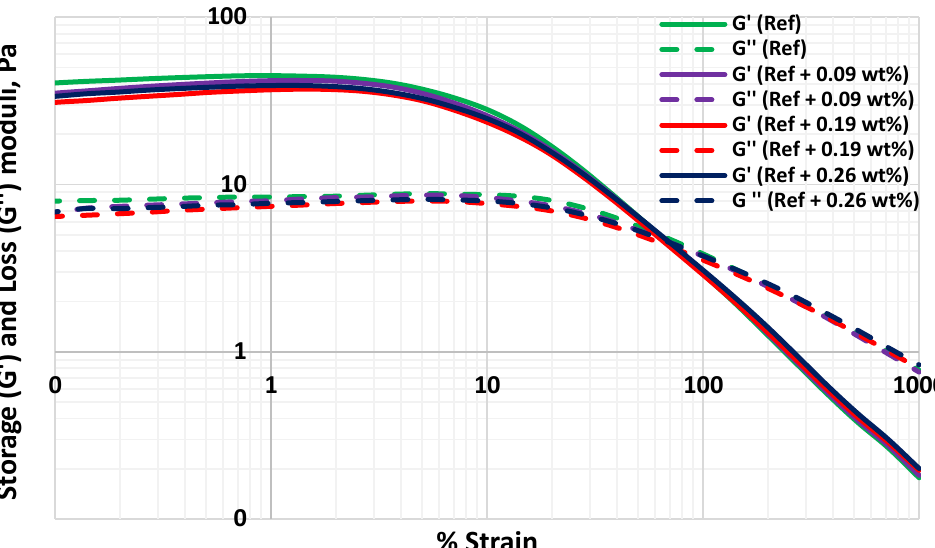
Figure 13. Dynamic amplitude tests of the drilling fluids. Table 2. Yield and flow point of the drilling fluids.